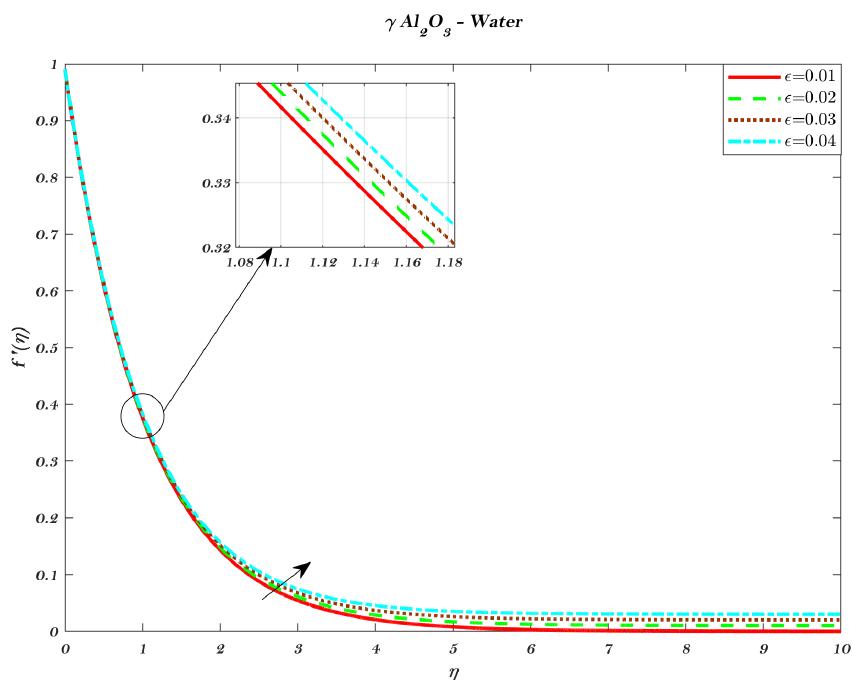
Figure 16. The effect of the stagnation parameter (cid:101) on the velocity profile with fix parameters ϕ = 3%, P r = 6.96 and ˘ a =